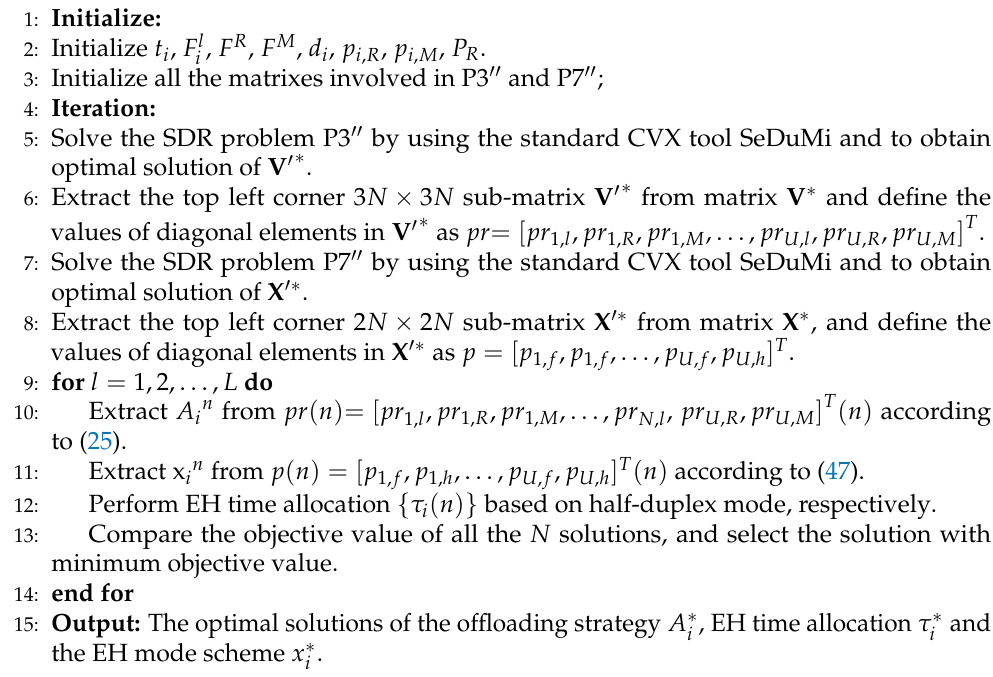
Algorithm 1 Jointly optimize the computation offloading decision, EH time allocation and mode